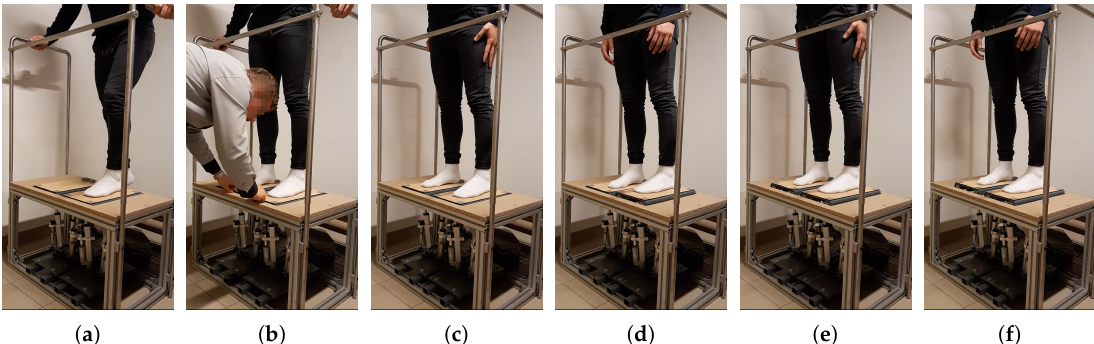
Figure 20. Experiment 3: ( a ) Volunteer 3 placing the left leg on the force plate; ( b ) a researcher helps Volunteer 3 set the left and right legs on their respective marked locations; ( c ) Volunteer 3 is balanced ( d ) LLD simulation by shortening the right (lengthening the left) leg by 15 mm (initial algorithm state k = 0); ( e ) algorithm iteration k = 1; and ( f ) Volunteer 3 is balanced (algorithm iteration k = 2).